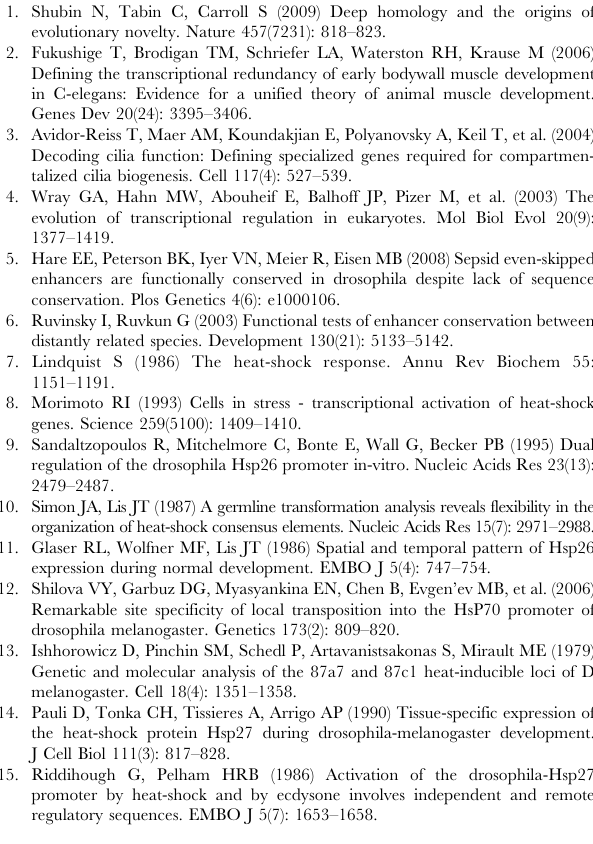
Figure S2 Sequences of cis -regulatory elements tested in this study. Species, names of the genes and the length of inserts are indicated as well as whether these were fused to GFP or mCherry. Figure S3 Controls. A) Endogenous expression of C. elegans genes act-2 and gpd-2 is not induced after heat shock. Expression of promoter-reporter gene constructs B) myo-2 ::mCherry and C) unc- 47 ::GFP is not induced after heat shock. Figure S4 Induction by heat shock of endogenous C. elegans and C. briggsae hsp-70 genes and of transgenic constructs fusing their promoters to GFP. Relative levels of induction were calculated based on the amount of expression just prior to the start of heat-shock treatment.